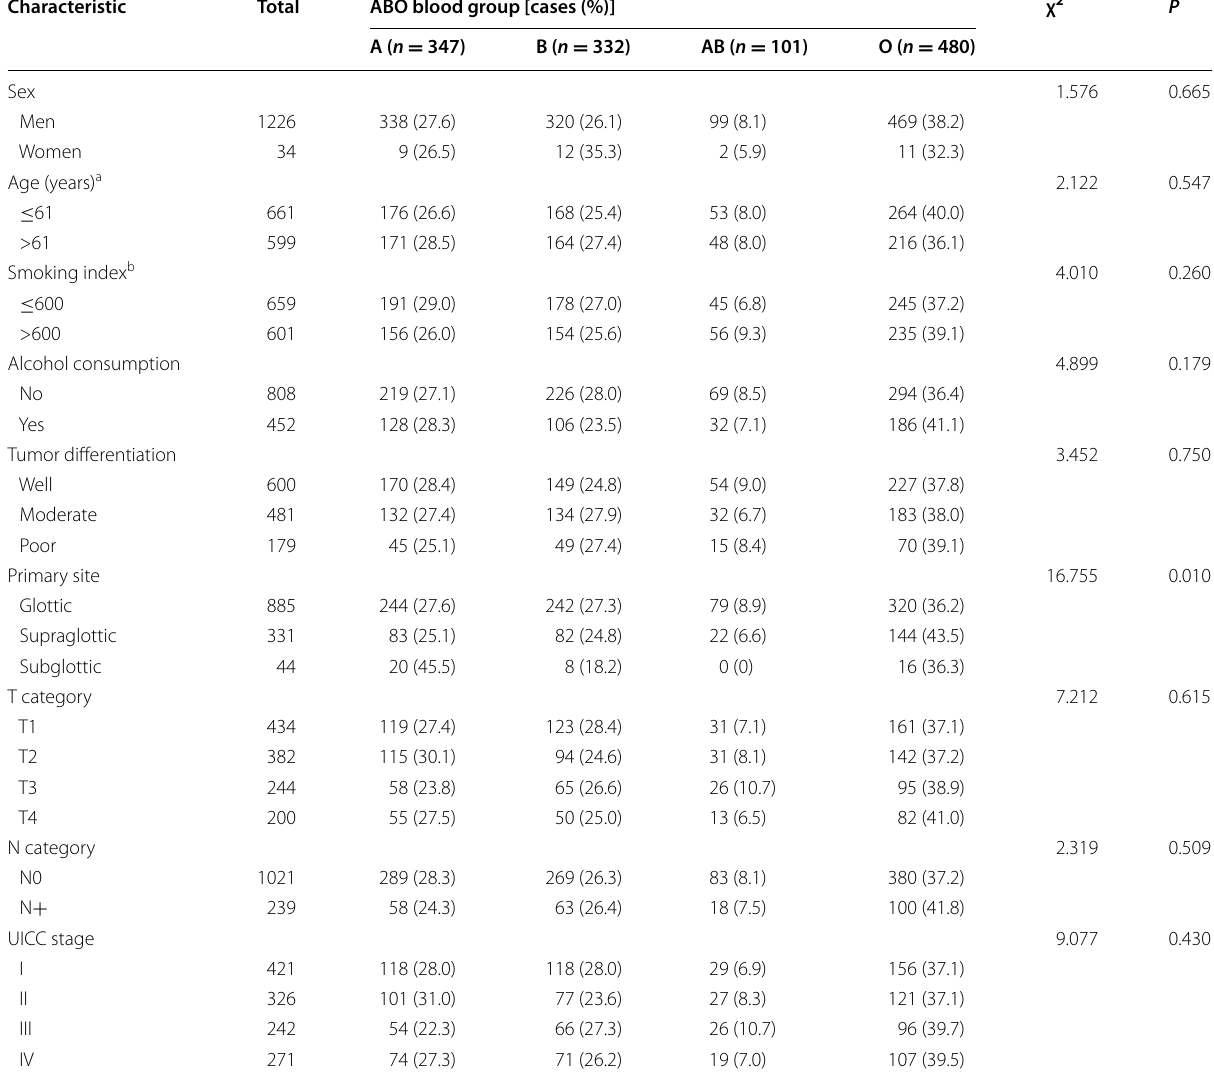
Table 1 Baseline characteristics of 1260 laryngeal cancer patients divided by different ABO blood